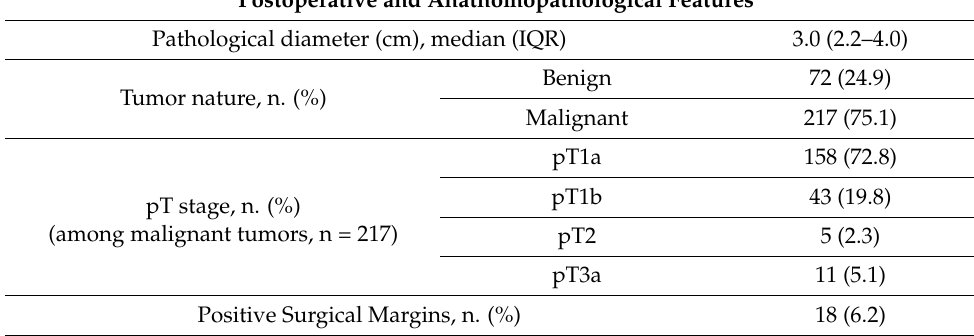
Table 2. Postoperative and histopathological features of 289 patients treated robotic PN for cT1- T2N0M0 renal